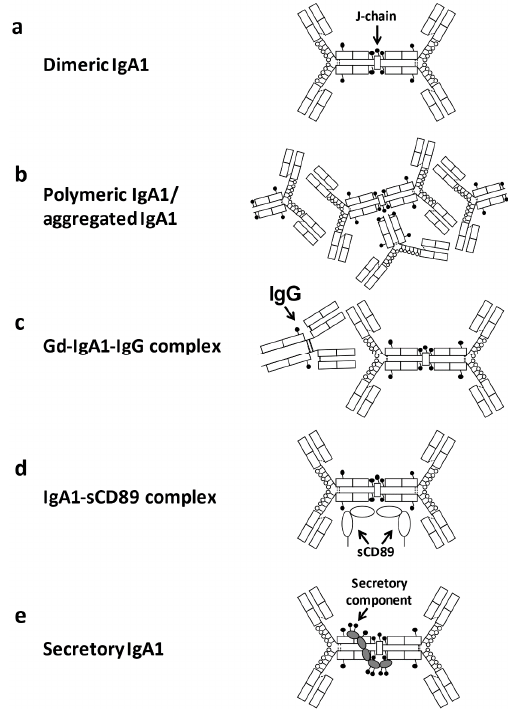
Figure 4. Macromolecular forms of IgA1. Although mesangially deposited IgA1 has not been fully characterized, Gd-IgA1-IgG (or IgA) immune complexes, IgA-IgA receptor complexes, self-aggregated IgA1 proteins, other serum protein complexes with IgA1, and secretory IgA1 are possible forms in the kidney deposits [23]. Dimeric IgA1 is composed of two monomeric IgA1 connected by joining chain (J chain) ( a ). Larger molecular forms of IgA1 may include complexes/aggregates of dimeric IgA1 and monomeric IgA1. Aberrantly glycosylated IgA1 may be prone to aggregation [127]. ( b ). Incomplete galactosylation of O -glycans in the IgA1 hinge region results in the exposure of terminal GalNAc and is recognized by autoantibodies (IgG of IgA), leading to the formation of IgA1-containing immune complexes ( c ). IgA1 complexes with soluble CD89 (sCD89) may be formed from CD89 cleaved from the surface of monocytes/macrophages ( d ). Secretory IgA1 consists of dimeric IgA1 with J chain and the secretory component ( e ). These macromolecular IgA1 forms ( a – e ) can form complexes with other serum